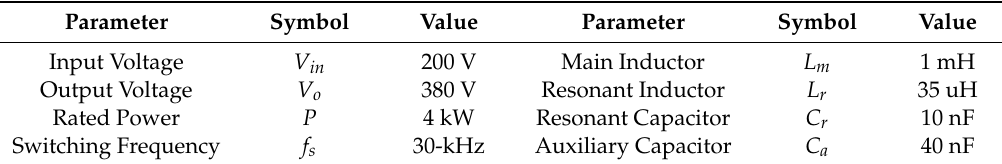
Table 1. Parameter of the proposed zero voltage transition (ZVT) converter.